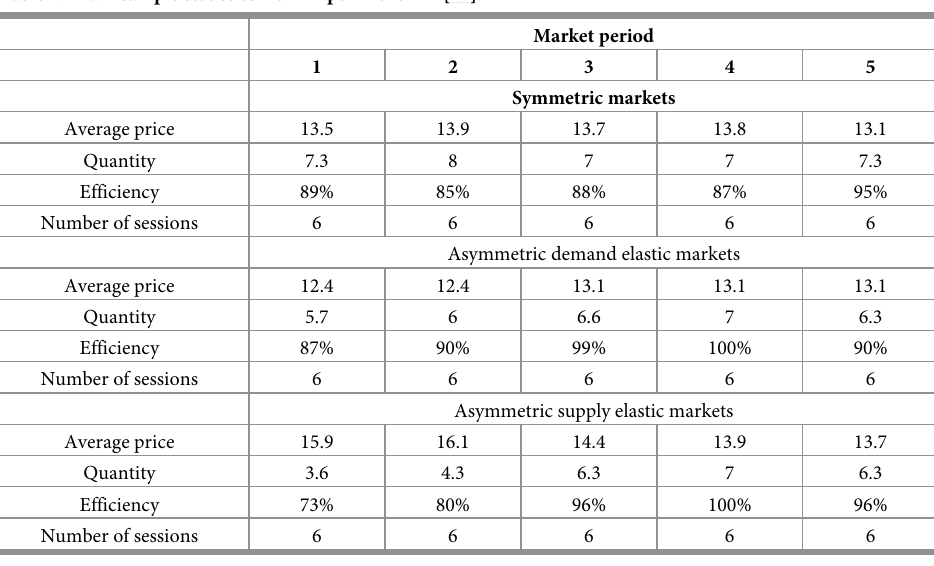
Table 1. Main sample statistics from Experiment 1 in